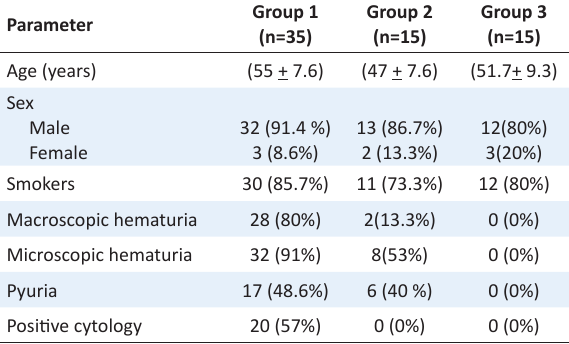
Figure 2 . PCR-RFLP results by Taq1 (T). 1, 2, 3 and 4 T are wild type.